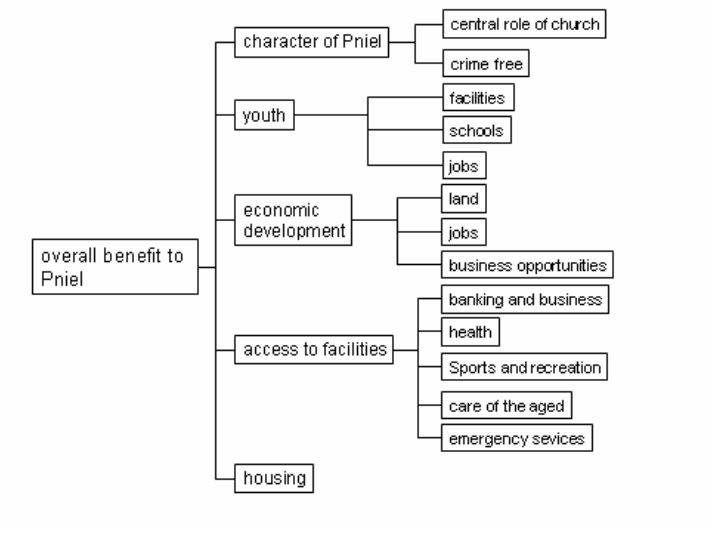
Figure 2: Value tree showing community assessments of need in